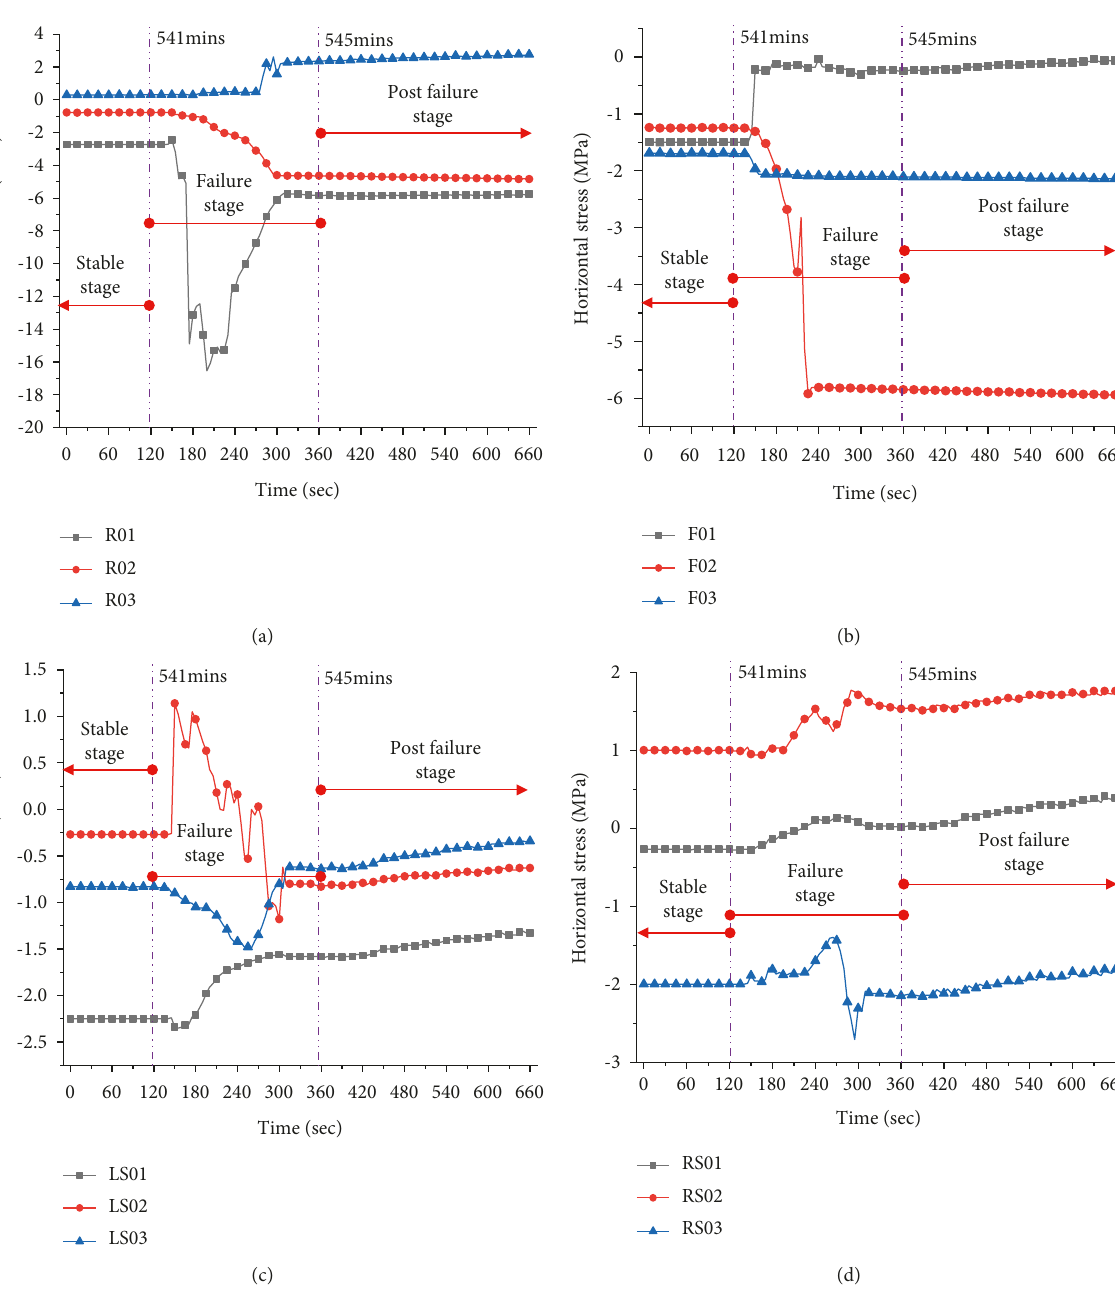
Figure 16: Horizontal stress of measuring points when the cumulative duration is 539–550mins; (a) R01, R02, and R03; (b) F01, F02, and F03; (c) LS01, LS02, and LS03; and (d) RS01, RS02, and